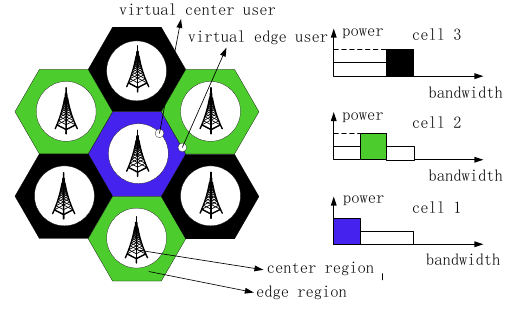
Figure 1. System